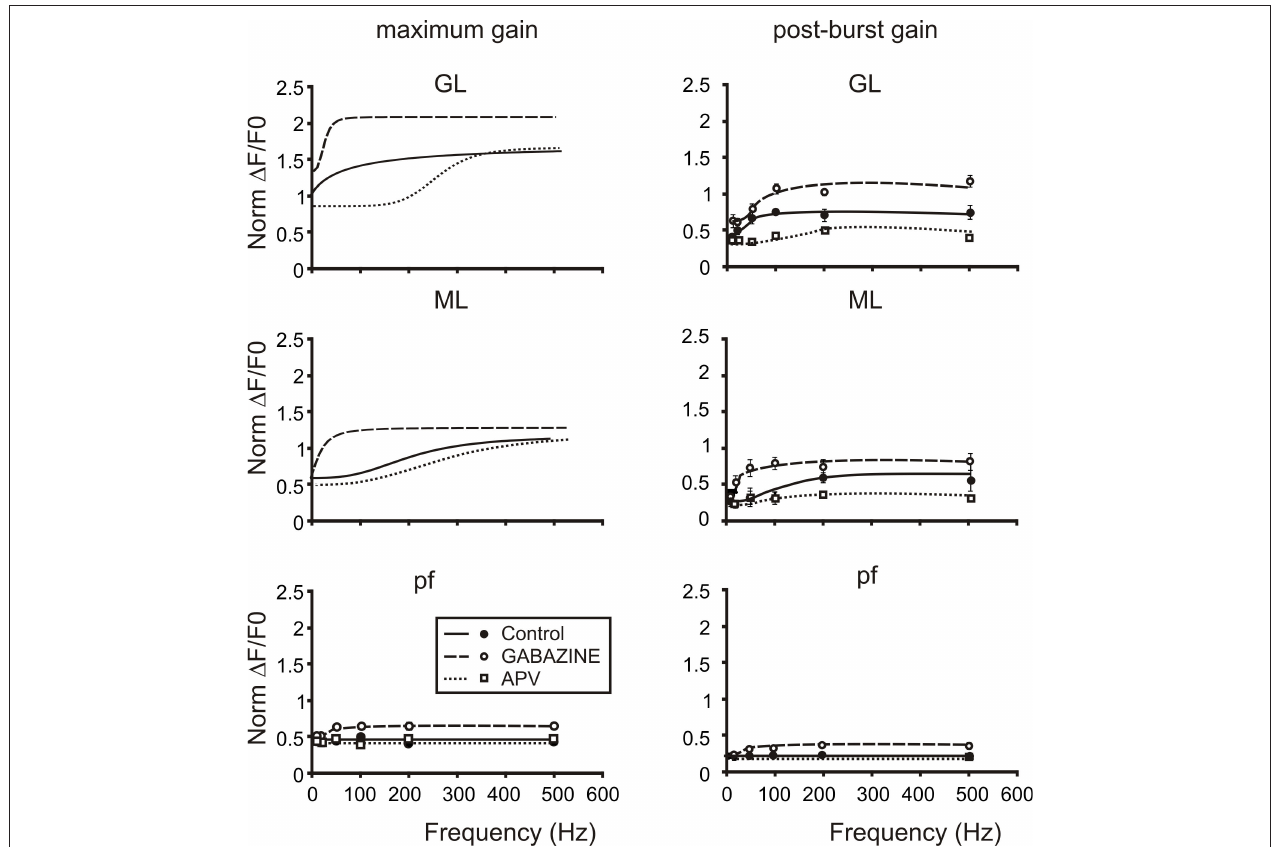
FiGure  | The cascade of filters from mossy to parallel fibers. Plots summarize the cascade filters generated from the mossy fiber to the parallel fibers. Signals conveyed through mossy fibers are primarily high-pass filtered by the granular layer. This first high-pass filter cuts signals below 50 Hz mainly through the activation of NMDA currents, in fact the application of APV (empty squares and dotted lines) shifts the cut-off frequencies of both gain and post- burst curves above 100 Hz. Moreover granule cell axons convey signals at the first Purkinje cells synaptic stage. Here a second filter cuts very high-frequency signals (100–200 Hz) mainly through the action of the inhibitory system. Note that gain and post-burst curves are poorly modified by the application of APV while the application of Gabazine (empty circles and dashed lines) significantly